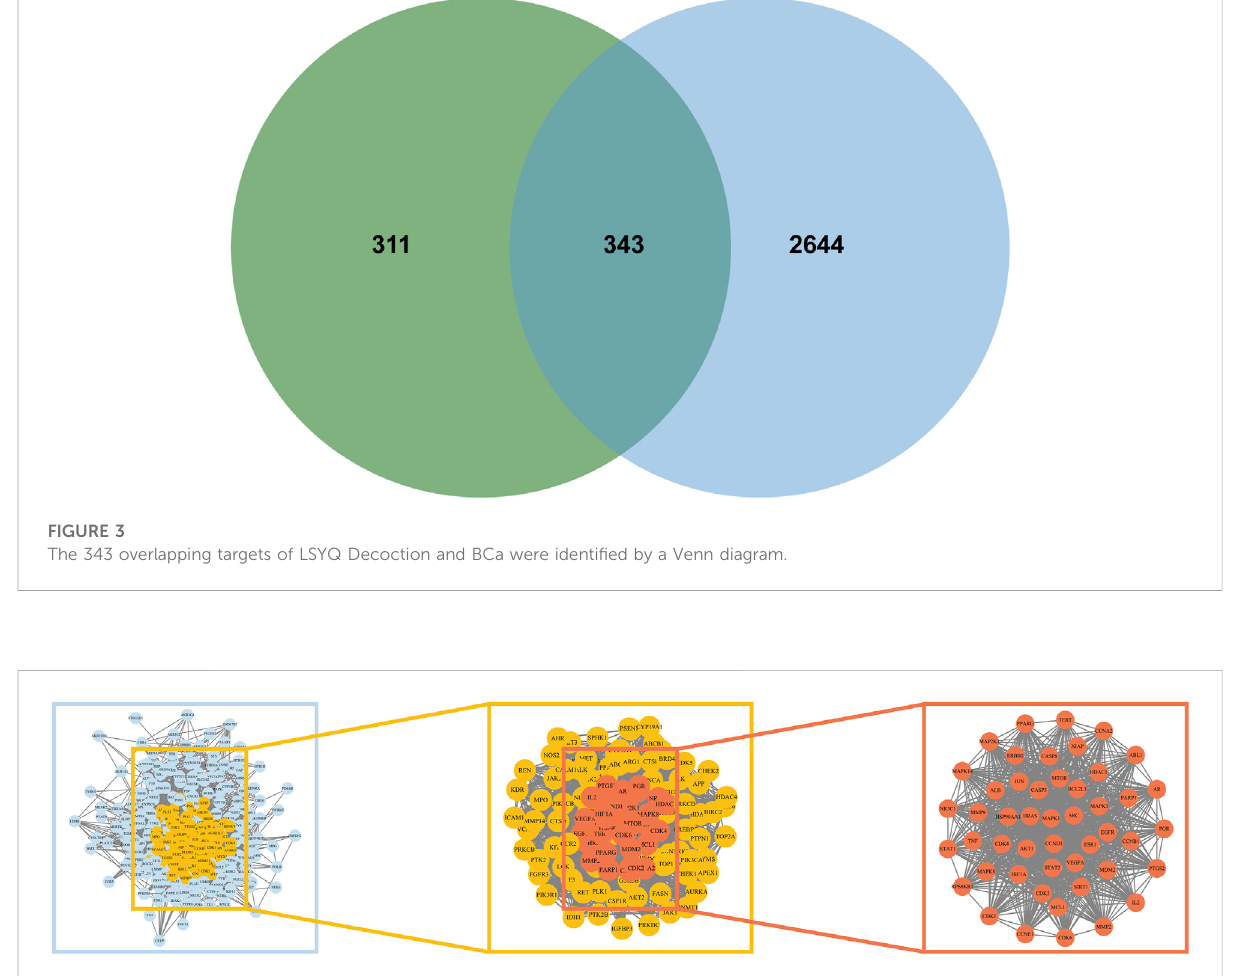
FIGURE 4 The process of screening the hub targets. The left panel showed the initial PPI network (339 nodes and 6,471 edges) of overlapping candidate targets.Themiddlepanelshowedthemedian- fi lteredPPInetworkwith133nodesand3,323edges.Therightpanel(ClusterOne)wasgeneratedasa result of MCODE module analysis from the middle panel. Cluster One had 48 nodes and 960 edges with a MCODE score of